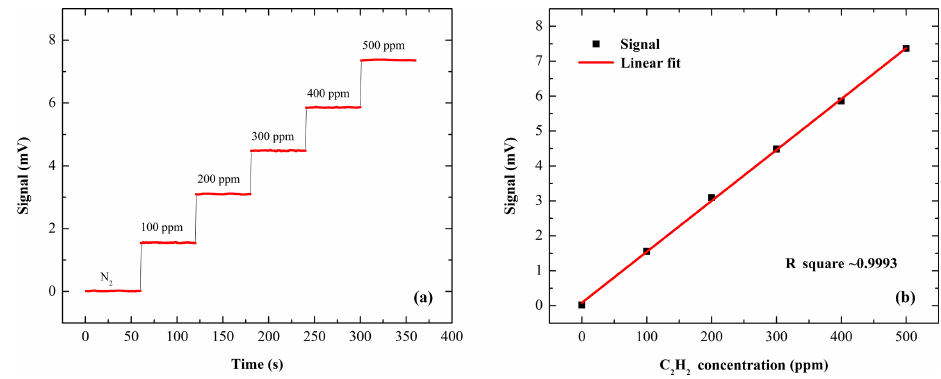
Figure 7. (a) CEPA signal at the different C 2 H 2 concentration levels. (b) Linearity of the CEPA sensor